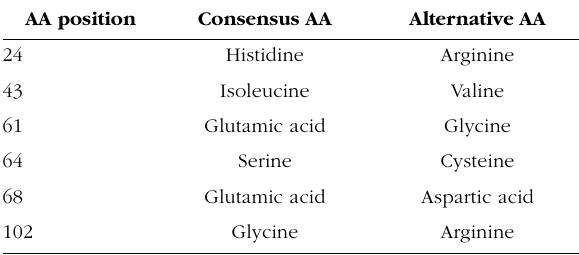
Table II. – Polymorphic amino acid (AA) sites in Ixodes ricinus glycerol-3-phosphate